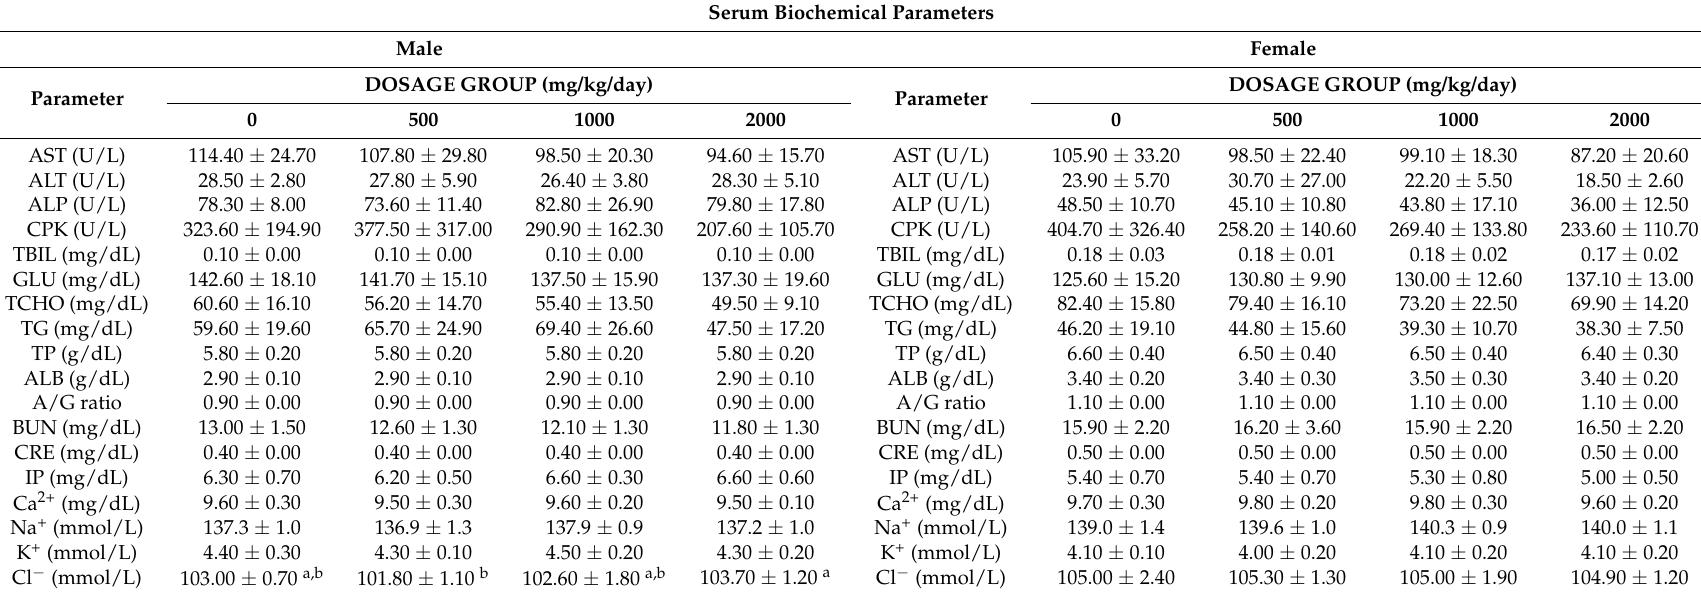
Table 7. Serum biochemical parameters in male and female rats given 500, 1000, or 2000 mg/kg/day GEE for 13 weeks in a repeated oral dose toxicity study. Serum Biochemical Parameters Male